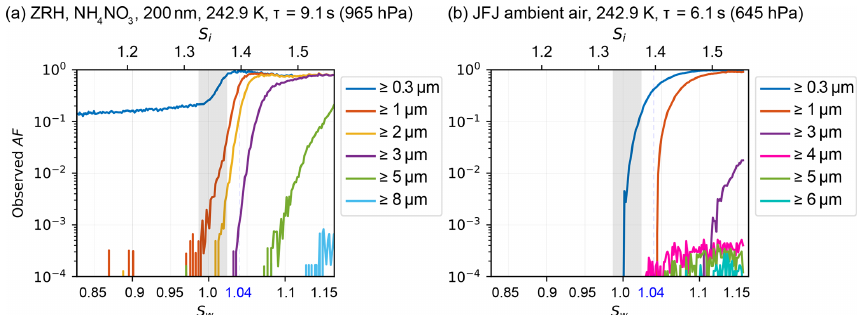
Figure 6. Activation curve at T = 243K for (a) ammonium nitrate, sampled in Zurich and (b) ambient air, sampled at JFJ during an period with enhanced INP concentrations. Both measurements were performed with HINC-Auto with an identical injector position but resulted in a shorter particle residence time ( τ ) at JFJ compared to Zurich because of the reduced ambient pressure. Grey shading refers to chamber uncertainty (see Sect. 3.1 for